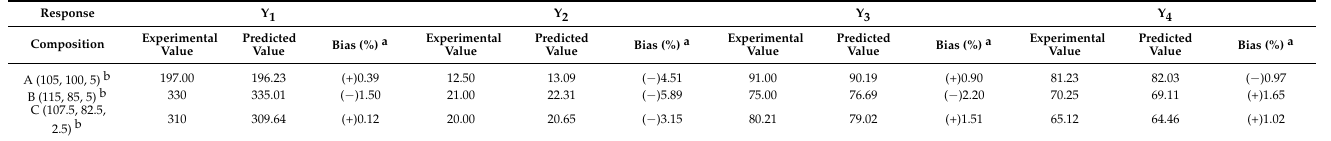
Table 7. The validation batches and the prediction error calculated as bias a (%).